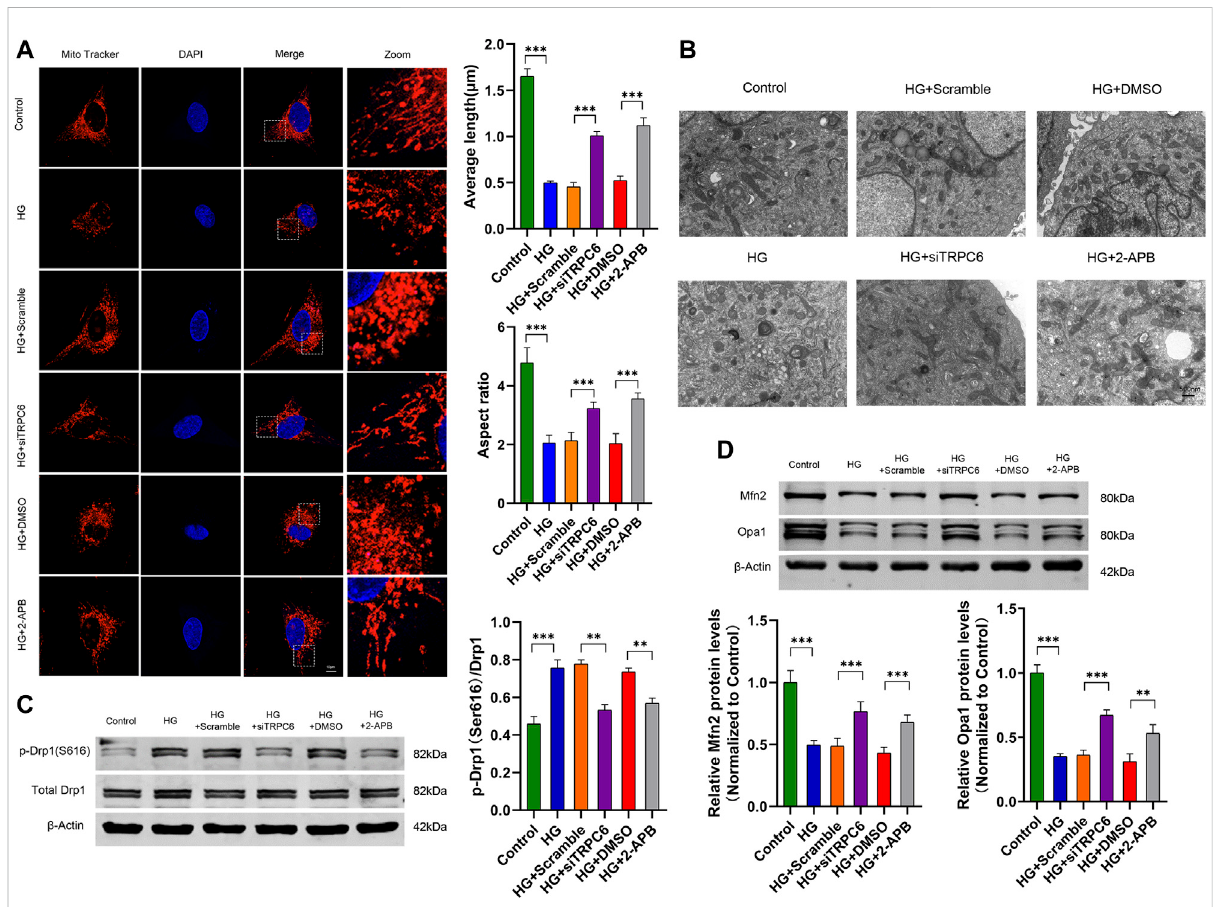
FIGURE 2 Effects of TRPC6 inhibition on mitochondrial morphology in podocytes under HG conditions. (A) MitoTracker Red and DAPI staining, and analysis of average length and aspect ratio by ImageJ software in the control, HG, HG + scramble, HG + siTRPC6, HG + DMSO and HG + 2-APB groups. Scale bars, 10 μ m ( n = 5 independent experiments). (B) Representative electron micrographs in the six groups. Scale bars, 500 nm. (C) Representative Western blot and quantitation analysis of p-Drp1 (Ser616) and total Drp1 in the six groups ( n = 3 independent experiments). (D) Representative Western blot and quantitation analysis of Mfn2 and Opa1 in the six groups ( n = 3 independent experiments). ** p < 0.01; *** p <